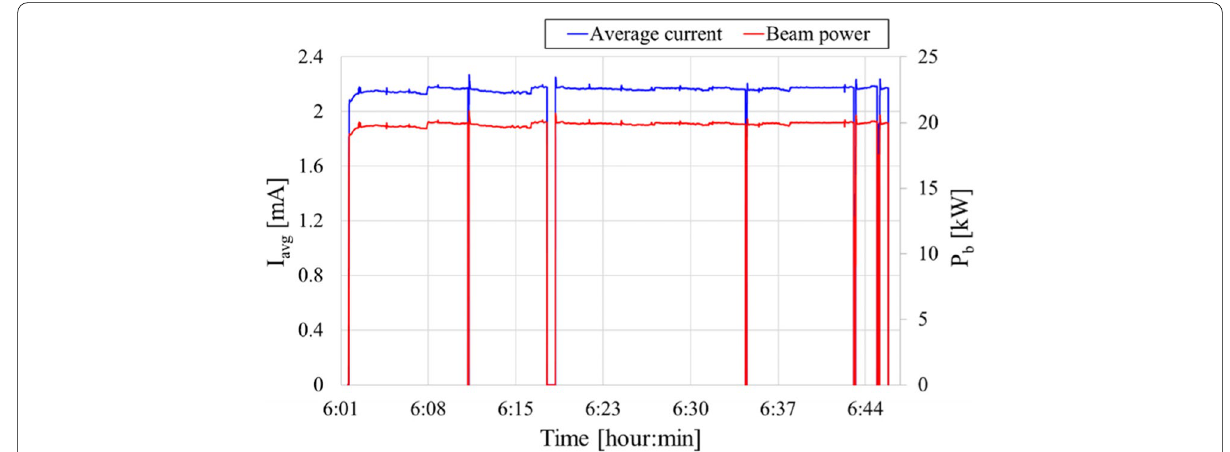
Fig. 13 The long‑run operation data shown are the average beam current ( I avg ) and the calorimetric beam power measurement ( P beam ). RF breakdown discharges are indicated by the vertical lines in the average beam current (blue line) and hence the calorimetric power measurement (red